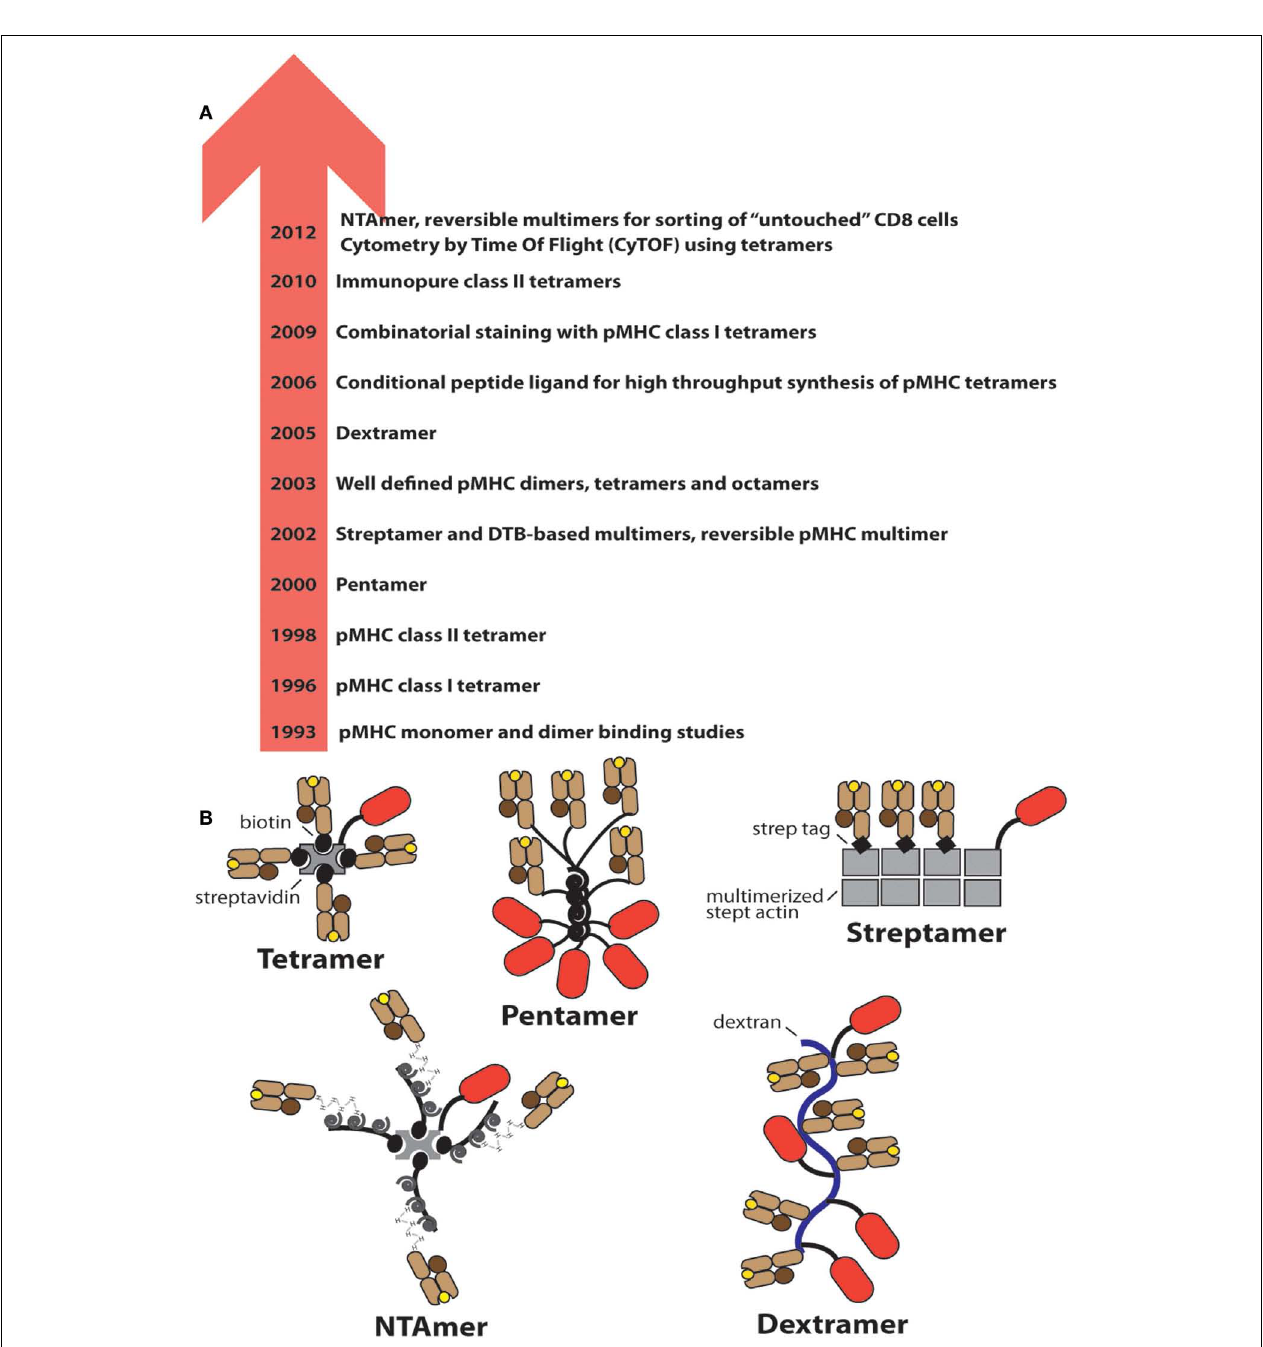
FIGURE 1 | Evolution of soluble pMHC complexes and their applications forT cell analysis and sorting . (A) Chronological listing of milestones in the use of pMHC complexes for the detection and analysis of antigen-specific CD8 + and CD4 + T cells. (B) Cartoons of the most frequently used pMHC oligomers; the red oval represents